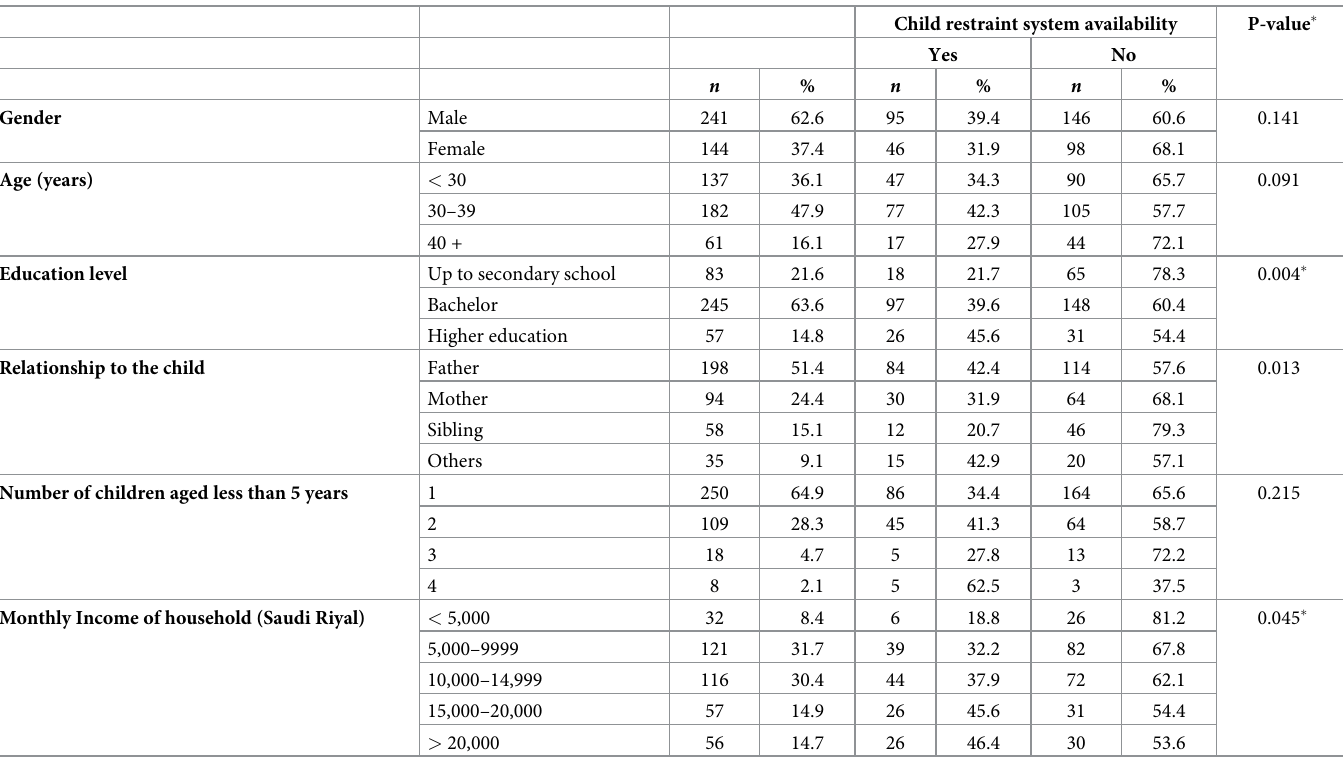
Table 1. Baseline characteristics of respondents and its association with child restraint system availability.